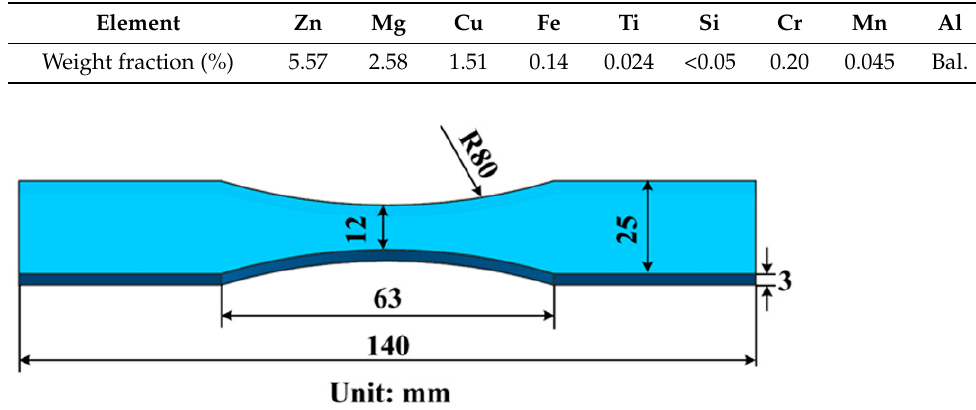
Table 1. Chemical composition (wt.%) of the 7075-T73 aluminum alloy. Element